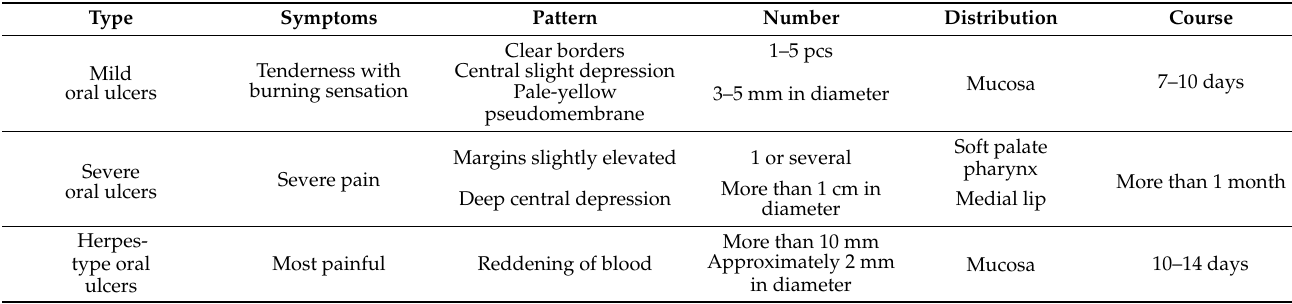
Table 1. Classification of recurrent oral